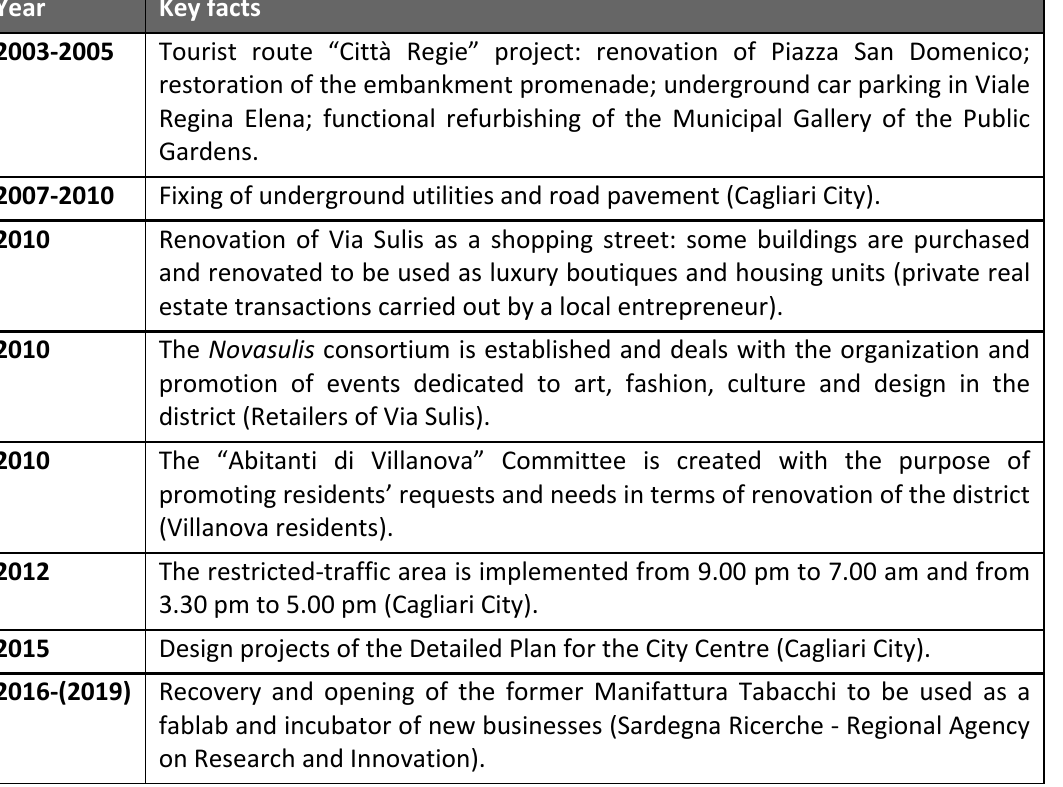
Table 1: Main events occurred in the Villanova District from 2003 to